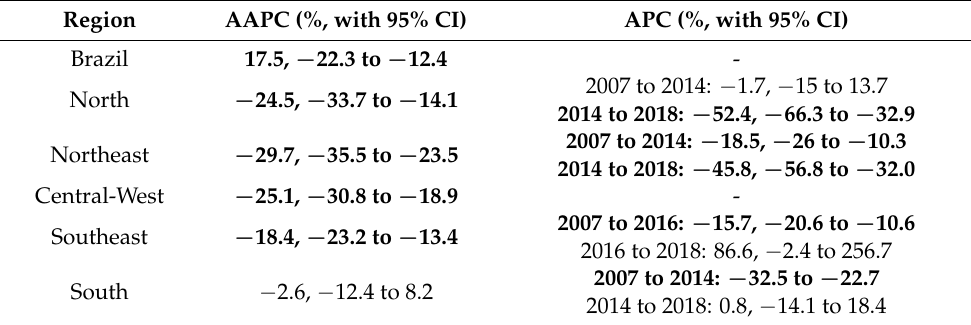
Table 1. AAPC and APC values with 95% CI of Brazil and its regions. In bold are trends that achieved statistical significance ( p < 0.05). Region AAPC (%, with 95% CI) APC (%, with 95% CI) Brazil 17.5, − 22.3 to −